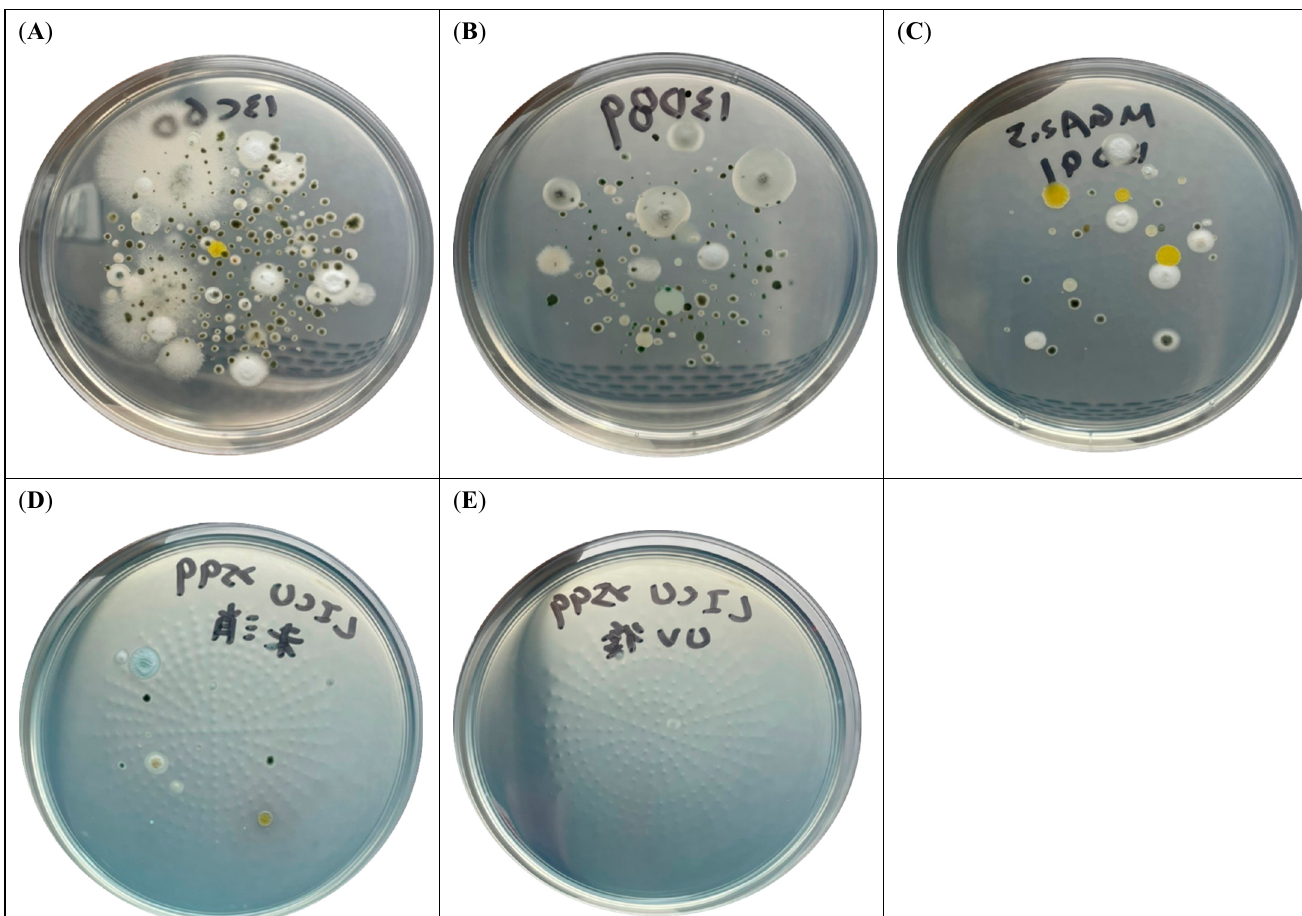
Figure 2. Representative agar plates inoculated by airborne fungi from the different hospital envi- ronments. Slightly negative air pressure rooms which had recently been renovated ( A ). Negative air pressure rooms ( B ). Rooms in the ordinary ward ( C ). Before and after environmental disinfection with ultraviolet-C (UV-C) irradiation (254 nm) in a liver intensive care unit room ( D , E ).